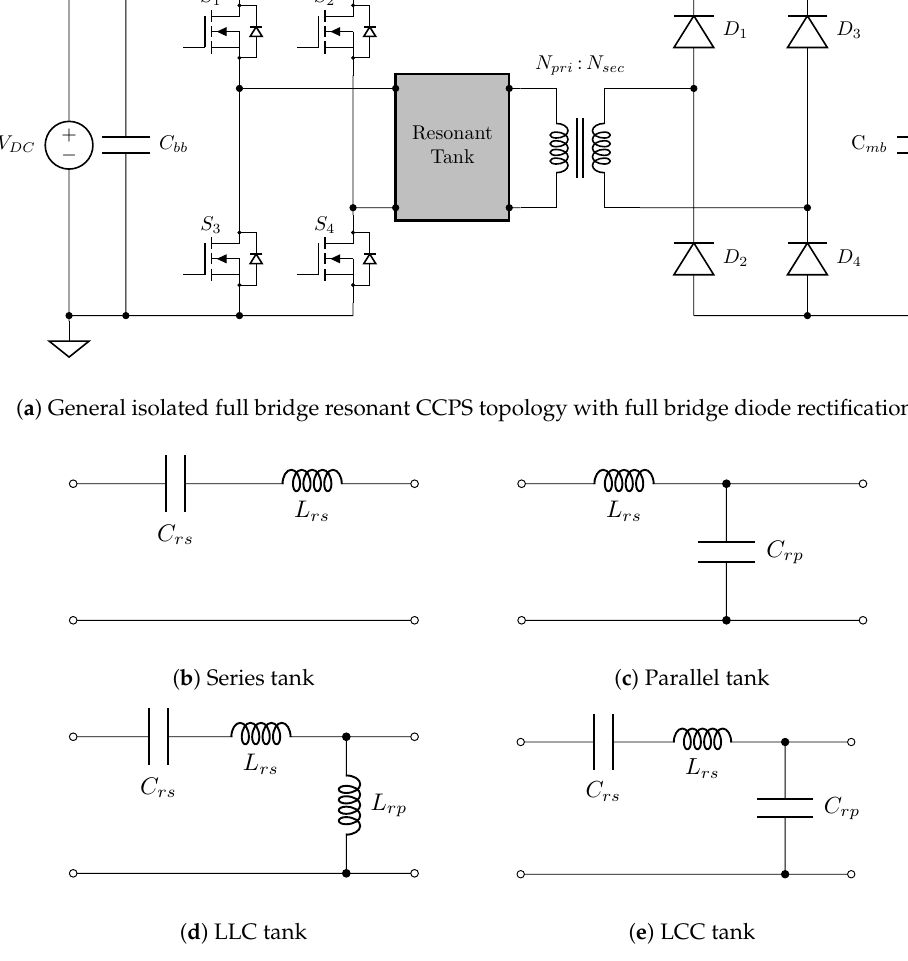
Figure 30. ( a ) General isolated full bridge resonant CCPS topology and ( b – e ) popular resonant tank circuit options as denoted (note: many other resonant CCPS variations are